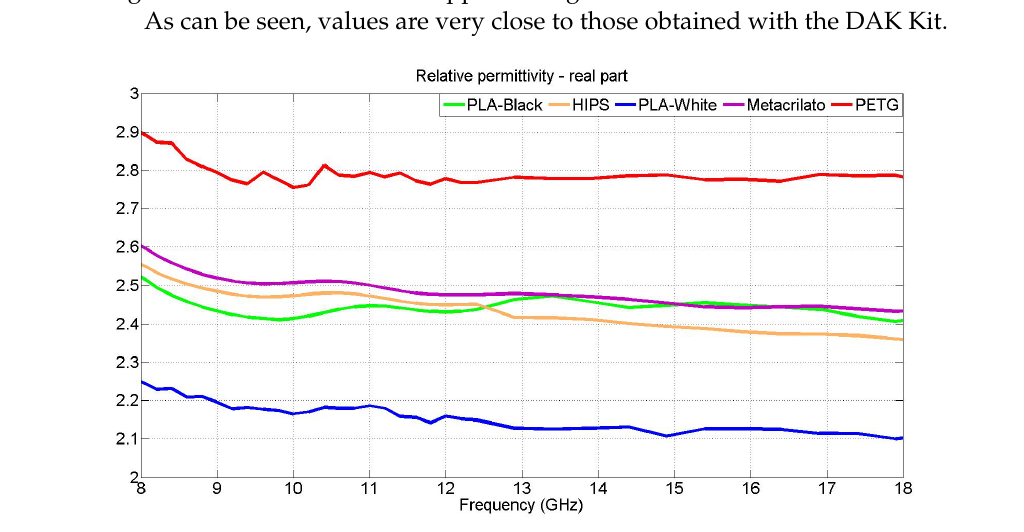
Figure 22. Comparison, from 8.5 to 20 GHz, between the values of the real part of the permittivity of methacrylate, HIPS, PETG and PLA, obtained by PSO